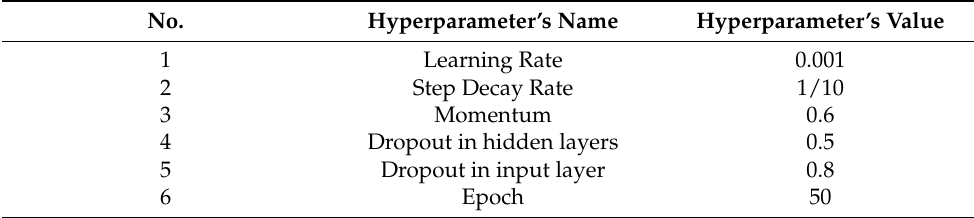
Table 1. Used hyperparameters.